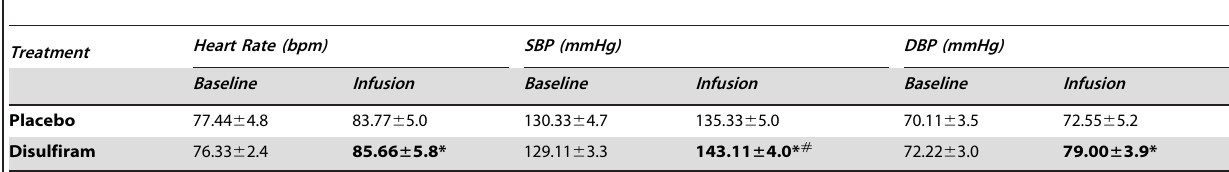
Table 3. Cardiovascular effects of disulfiram following a cocaine choice infusion.